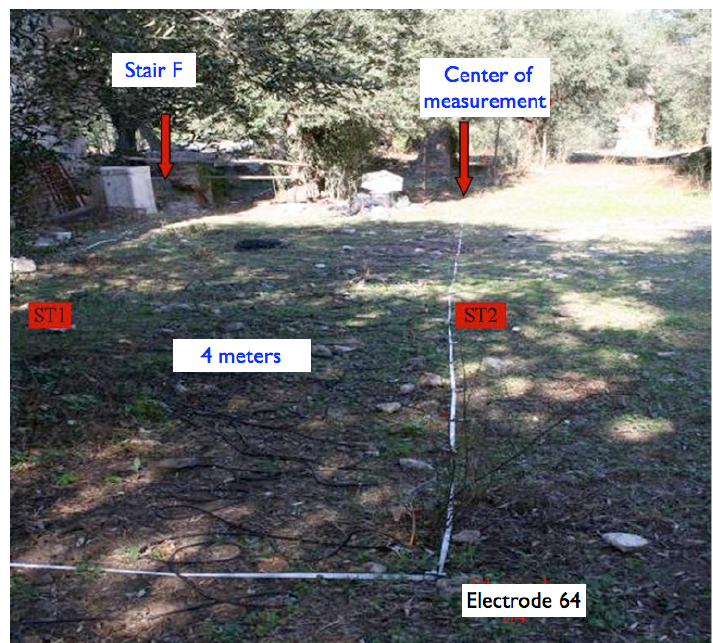
Fig. 11. View of the surveyed area in the northern part of the inner porch, with part of the measuring grid (photo A. M. Marras).